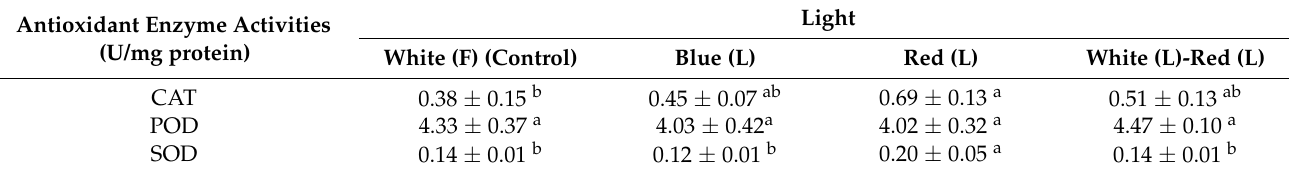
Table 4. Effect of different light conditions on ( a ) catalase (CAT), ( b ) peroxidase (POD) and ( c ) super- oxide dismutase (SOD) activities in L. aestivum in vitro plants. The results are means of 3 replicates ( n = 3) ± SD. Different letters indicate a significance difference at p < 0.05 according to ANOVA and Duncan’s test. F: fluorescence, L: LED